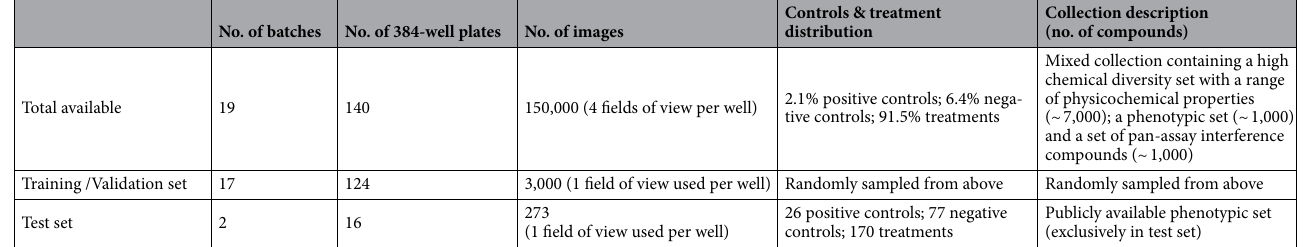
Table 1. The composition of the Training, Validation and Test sets. Choosing data from many batches and experiments should make our models learn more robust, common features, which gives us the best chance of successful prediction on unseen